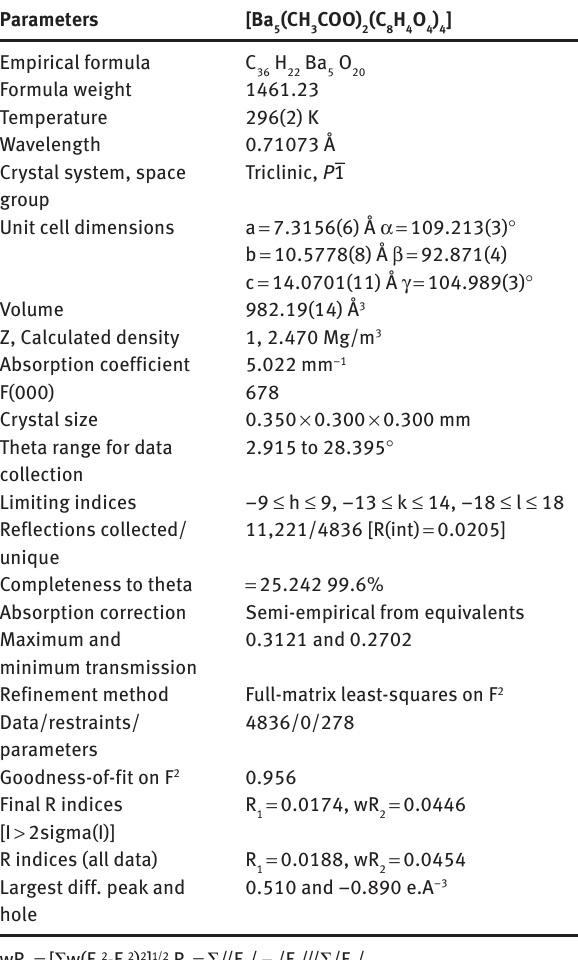
Table 1: Crystal data and structure refinement parameters of